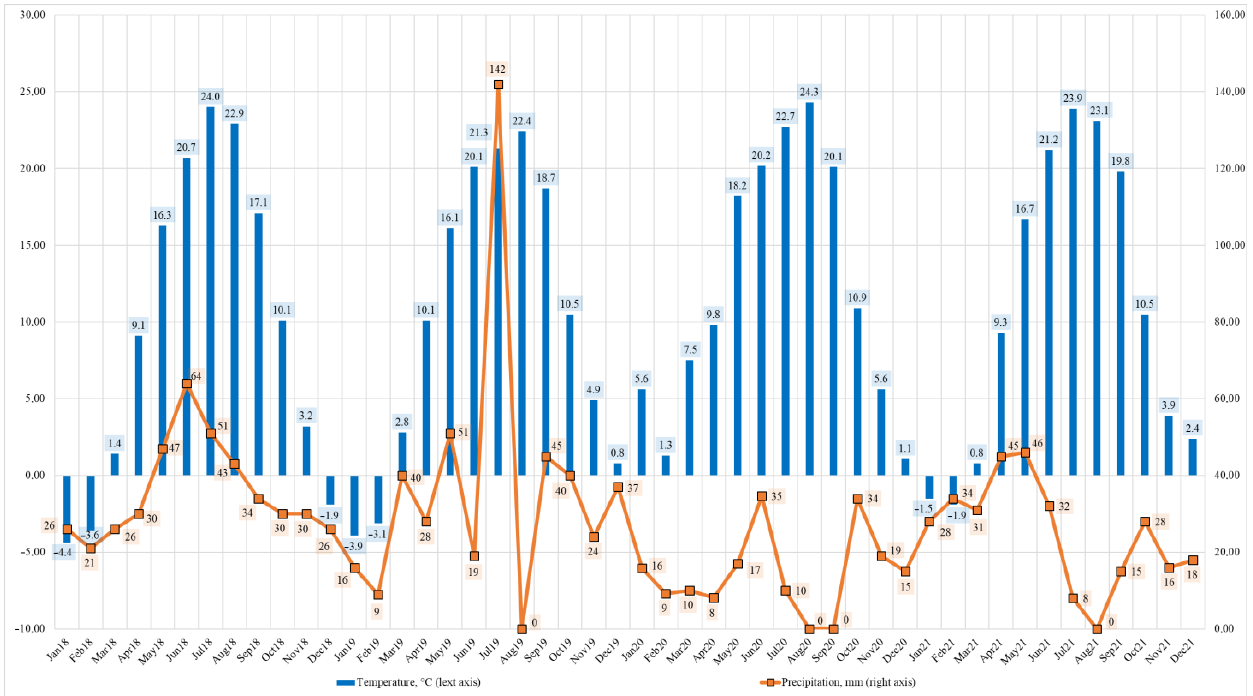
Figure 2. Meteorological parameters: temperature and precipitation. Source: authors’ development based on the Stavropol Center for Hydrometeorology and Environmental Monitoring [78].